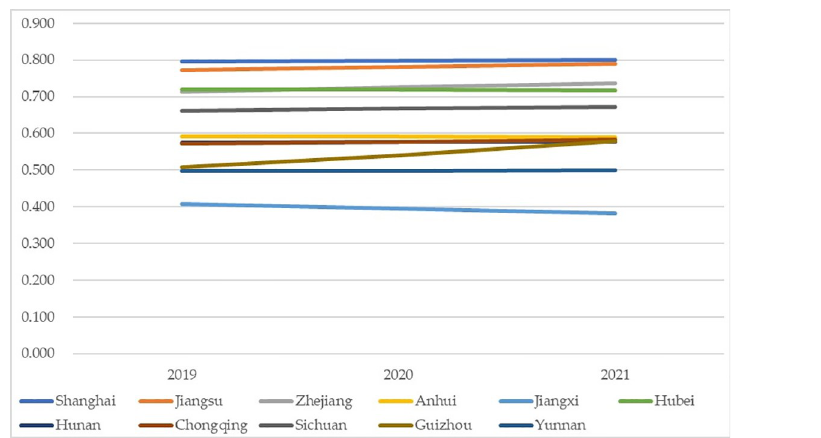
Fig 10. Coordinated growth performance